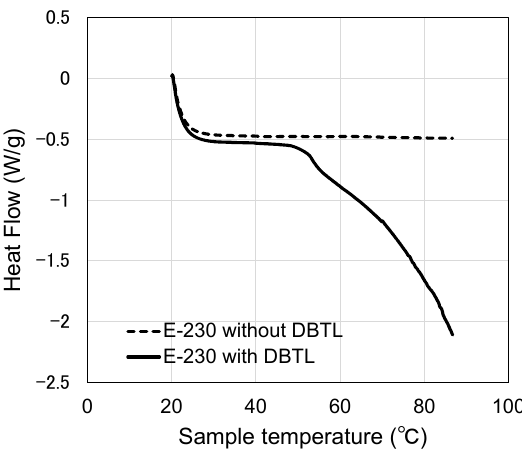
Figure 15. DSC profile of the E-230 solution with or without DBTL.